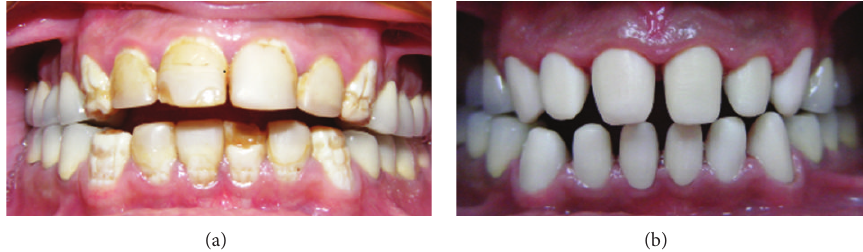
Figure 5: (a) Cemented posterior crowns fabricated from feldspathic porcelain using Laser Sintering technology. Vertical occlusal dimension was established according to the measurements. (b) Zirconium frameworks produced using a 5-axis CNC